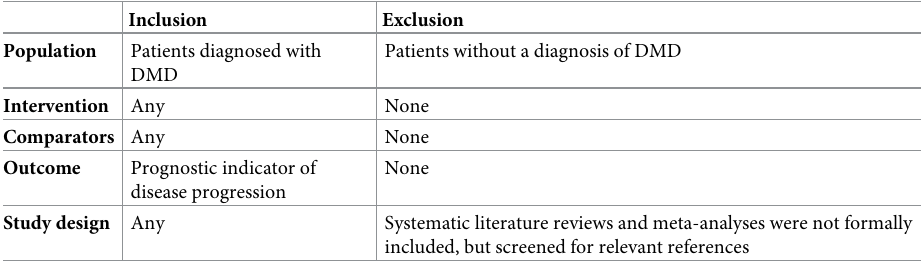
Table 1. PICOS eligibility criteria for study